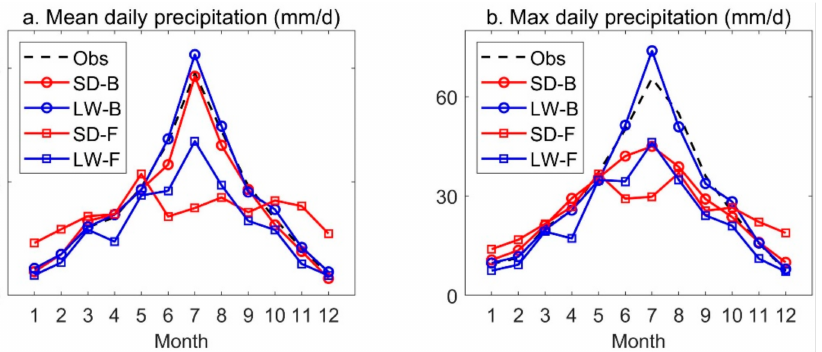
Figure 2. Mean ( a ) and maximum ( b ) daily precipitation in the baseline (1961–2000) and future periods (2060–2099) projected by the SDSM and LARS-WG downscaling models. The on-site obser- vations, baseline simulations by SDSM, baseline simulations by LARS-WG, future simulations by SDSM, and future simulations by LARS-WG are denoted by “Obs”, “SD-B”, “LW-B”, “SD-F”, and “LW-F”,